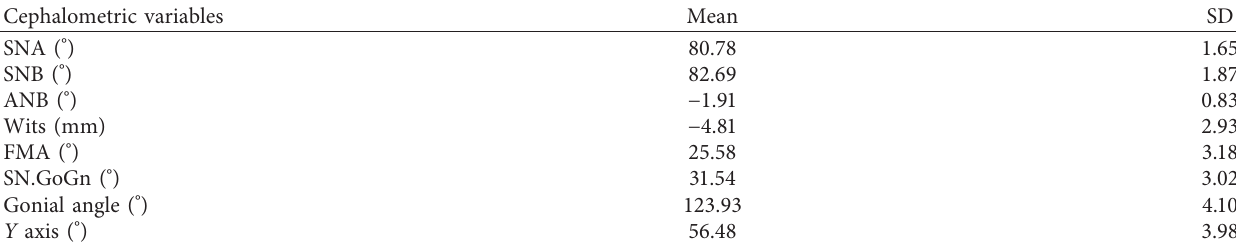
Table 1: Mean and standard deviations of the initial cephalometric measurements of the